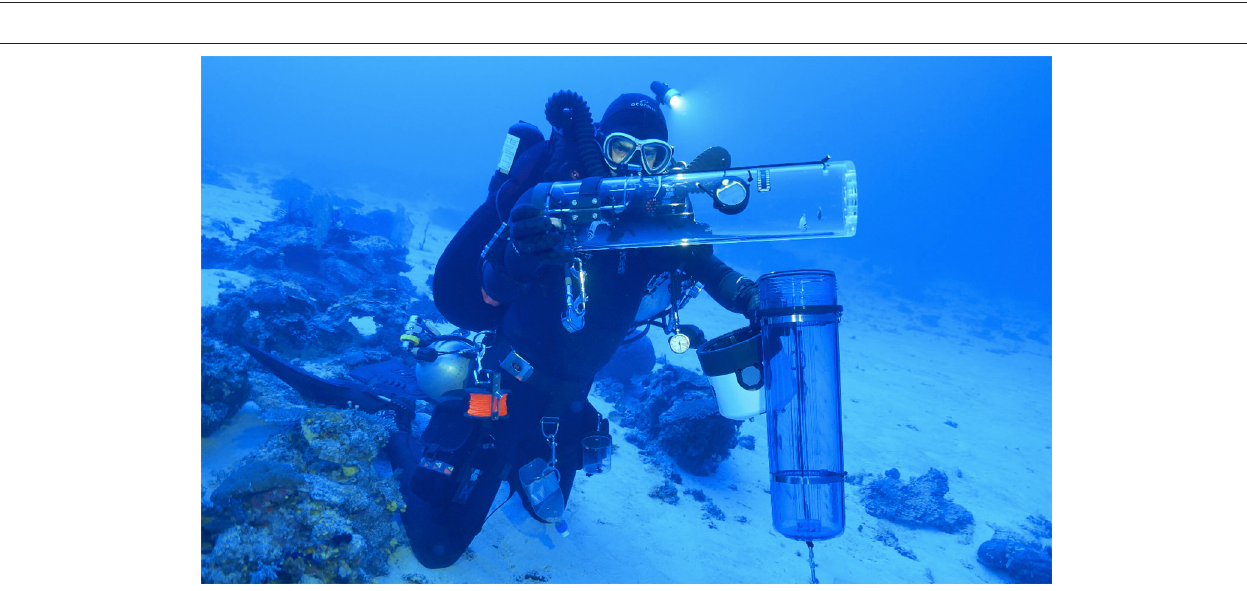
FIGURE 4 | Schematic of the hyperbaric chamber in field use, showing: (A) pair of hyperbaric chambers containing mesophotic fishes, (B) seawater reservoir, (C) high-pressure pump (D) control manifold with in-line pressure gauge and adjustable pressure control valve, (E) aquarium life support equipment for filtration and temperature control. Arrows indicate water flow direction. Black lines denote 6mm water supply tubing, gray lines represent 12mm water discharge tubing, and the dashed line signifies the 6mm bypass tubing connection. Circles marked with diagonal lines represent the valves used for flow-control and to isolate the chambers.